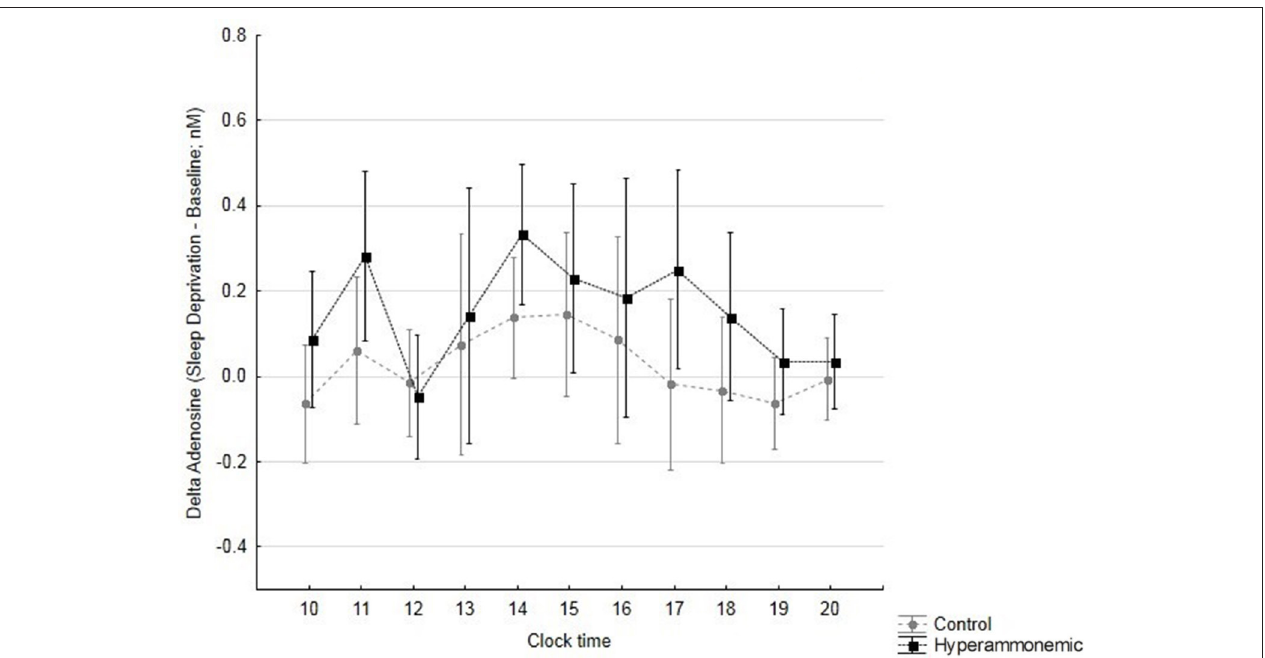
FIGURE 6 | Differences in adenosine levels (sleep deprivation – baseline, with sleep deprivation starting at 11h; mean ± 95% confidence interval) over time, in control (gray circles) and hyperammonemic (black squares) animals. time: F = 2.4, p = 0.012; group: F = 4.9, p = 0.047; time * group: F = 0.5, p = 0.829.